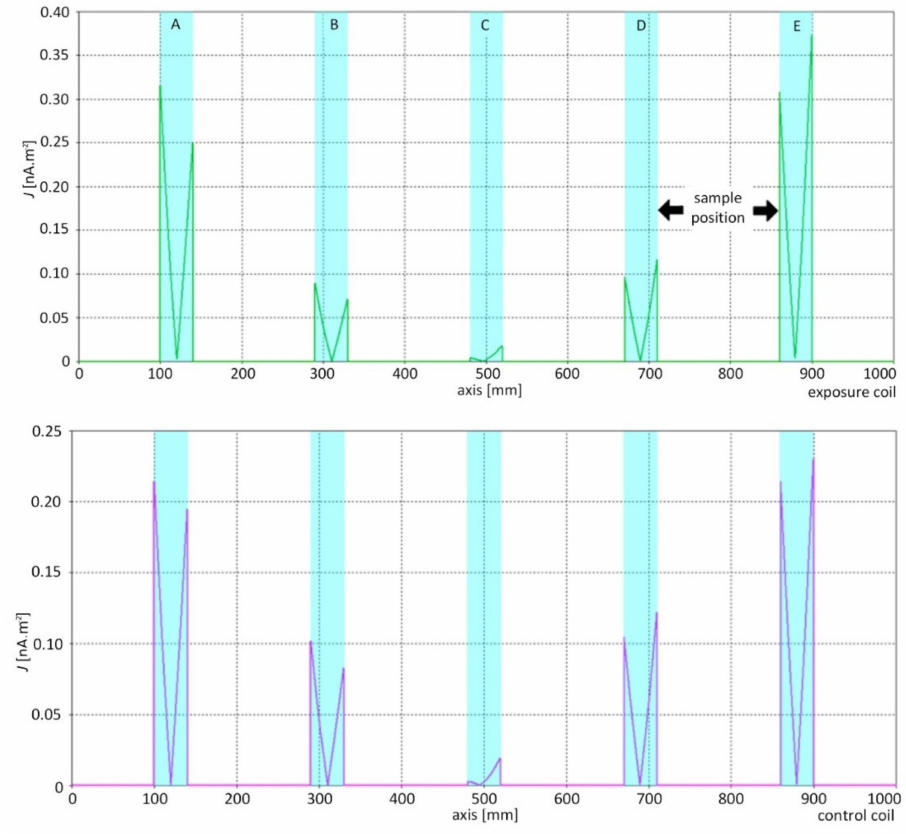
Figure 5. Total current density in exposure and control coil, data from CST Studio